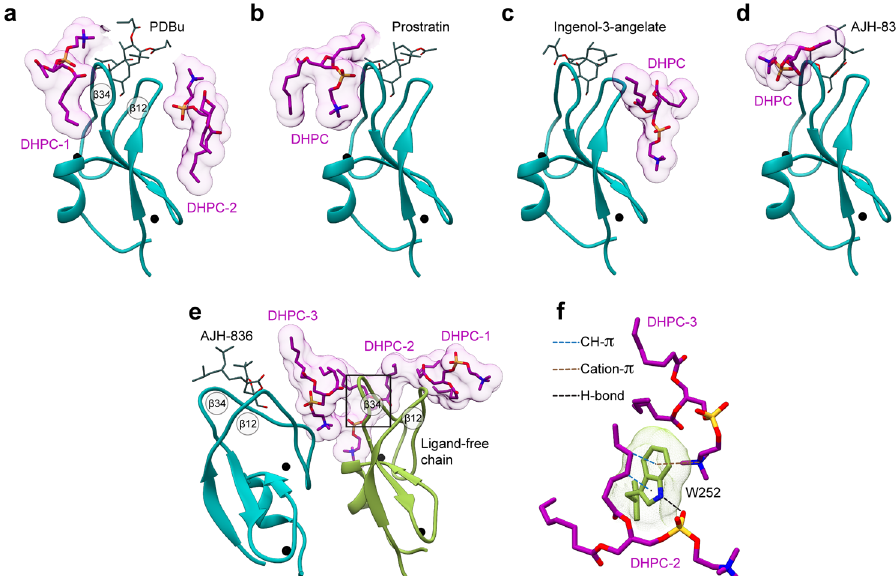
Fig. 4 Peripheral DHPC molecules in the C1B δ -ligand complexes. DHPC molecules peripherally associate with the membrane-binding loop regions of C1B δ complexed to a PDBu; b prostratin; c ingenol-3-angelate, d AJH-836 (one molecule per AU), and e AJH-836 (two molecules per AU). In e , one protein chain is ligand-free (color-coded green) and has three DHPC molecules, labeled 1 through 3 that cap the membrane-binding loop region. f The versatility of potential Trp252-lipid interactions, exempli fi ed by the Trp252 sidechain from the ligand-free C1B δ monomer ( e green). In addition to non- polar contacts with the hydrophobic lipid moieties, the Trp sidechains can engage in H-bonding, cation – π , and CH – π interactions.